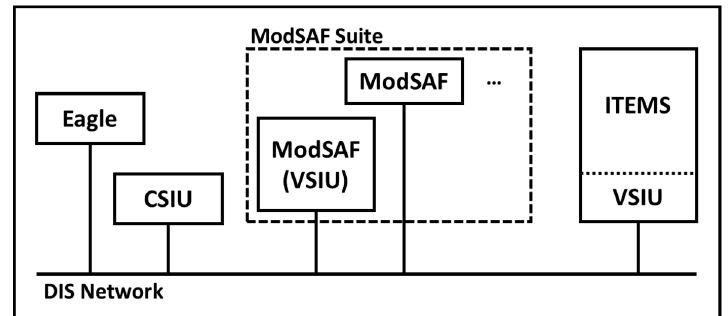
Figure 11. Eagle/ITEMS network configuration and implementation (adapted from [41]). Figure 11. Eagle / ITEMS network configuration and implementation (adapted from [41]).